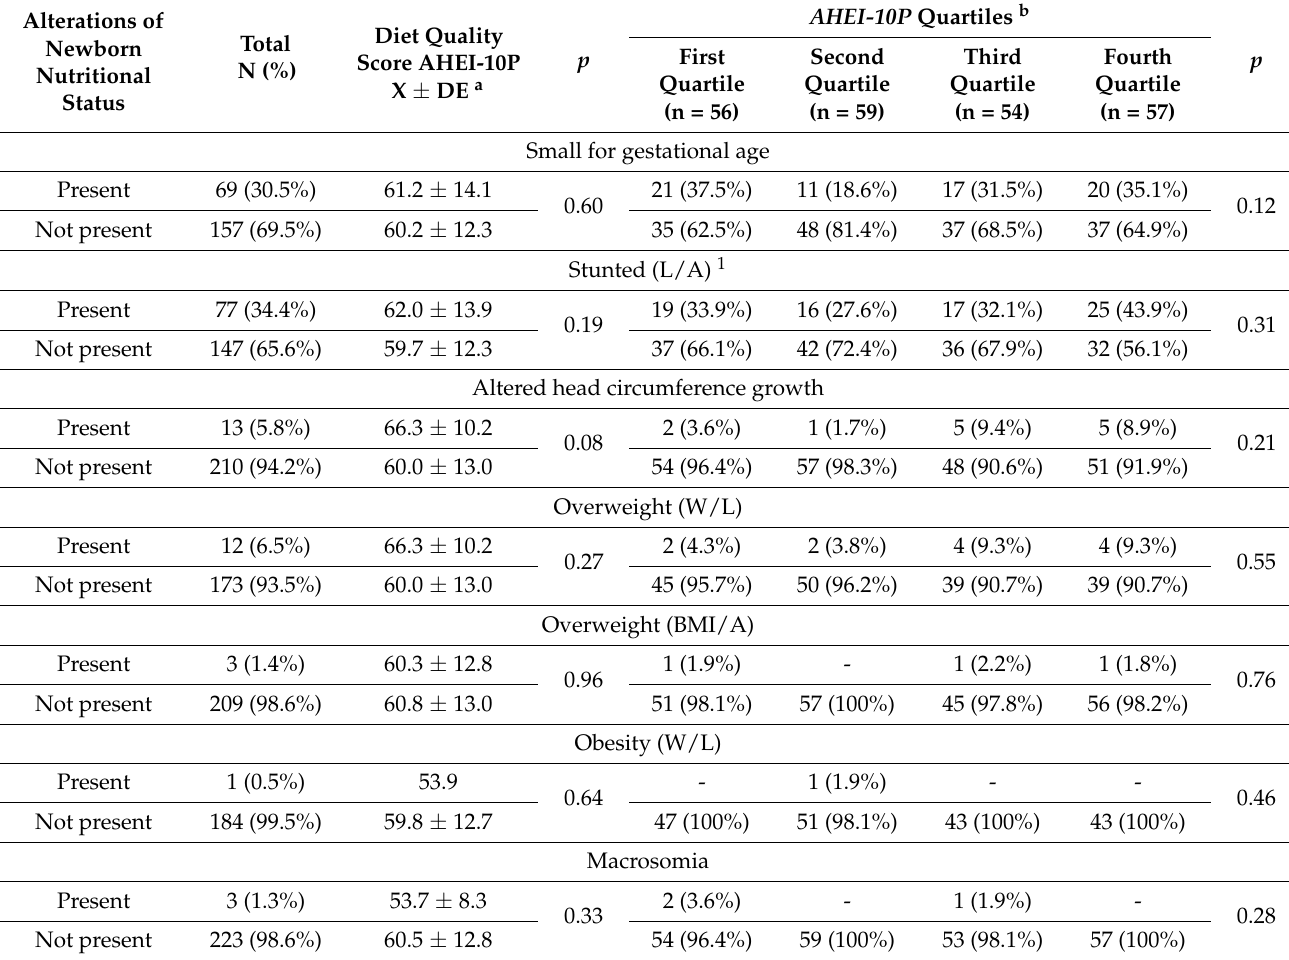
Table 4. Newborn nutritional status according to the AHEI-10P